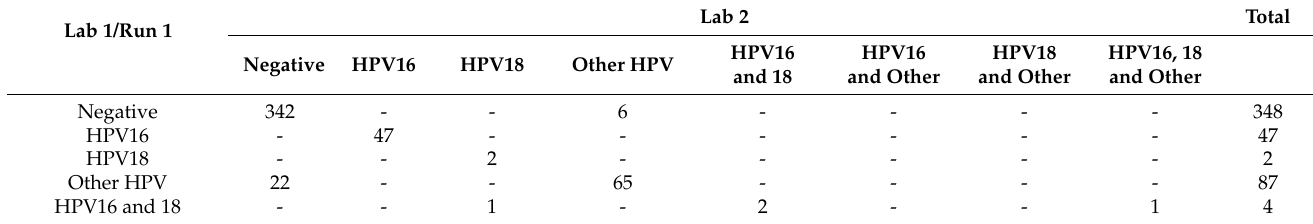
Table 4. Inter-laboratory genotype agreement 1